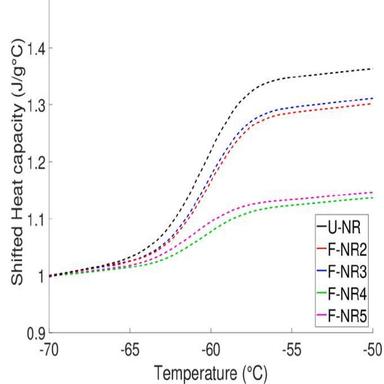
Shifted MDSC results for all grades of NR to compare Tg, heat capacity rise and breadth of transition.